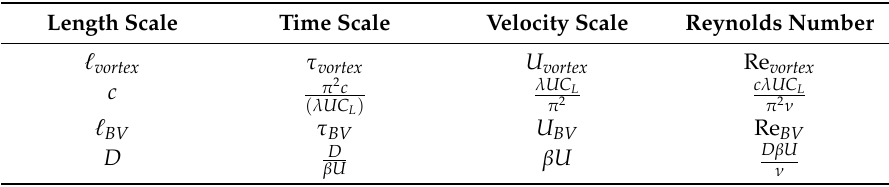
Table A2. Characteristic vortex scales in VAWT turbines.